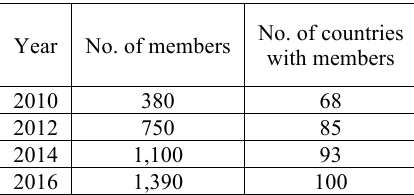
Figure 4. Percentage of members by geographical region for 2012 (Kivilcim et al., 2012).